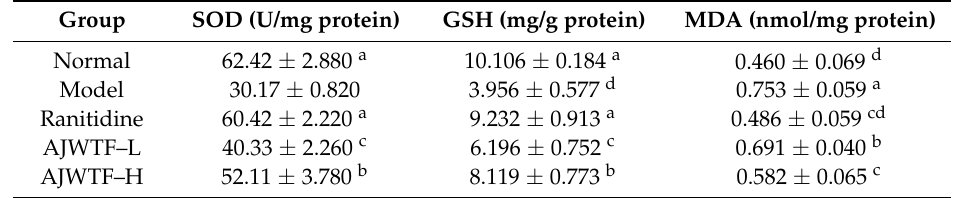
Table 5. Superoxide dismutase (SOD) and glutathione (GSH) activities and malondialdehyde (MDA) level in stomach tissues of mice from each group ( n = 10).